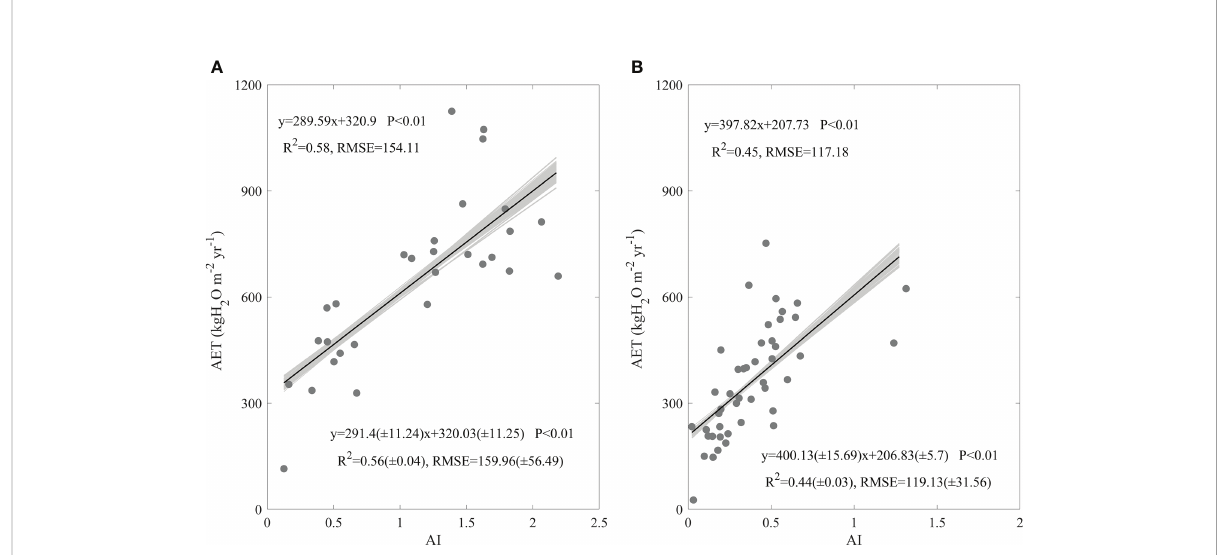
FIGURE 5 Effects of aridity index (AI) on the spatial variations of annual evapotranspiration (AET) in forests (A) and grasslands (B) in China. The grey lines are regression lines generated from the random error adding AET, whose statistics are presented in the right bottom of each